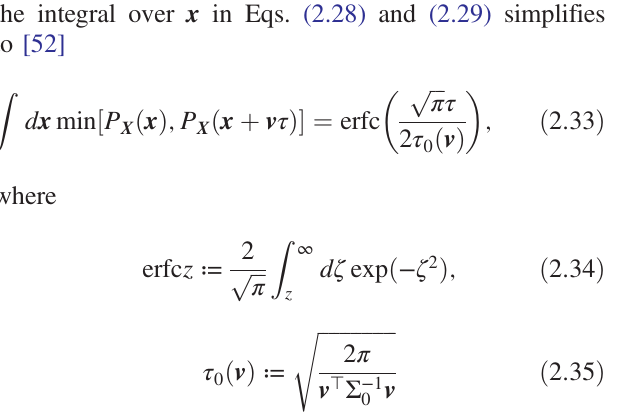
FIG. 1. The erfc function and a lower bound using the triangle function Λ .